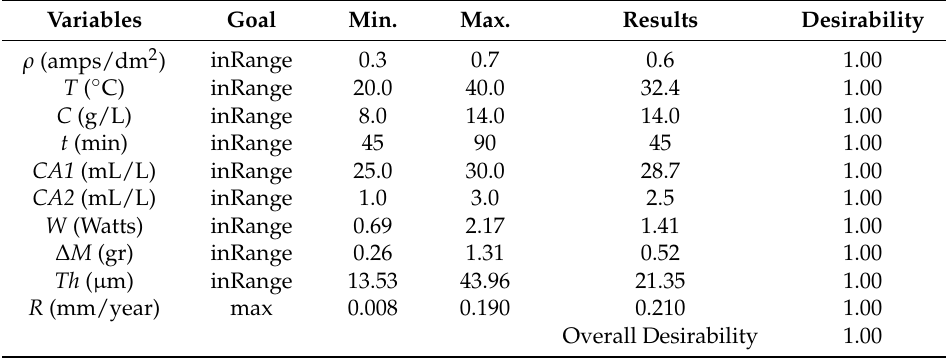
Table 12. The third criterion that was considered: maximizing the corrosion resistance of the coating ( R ).